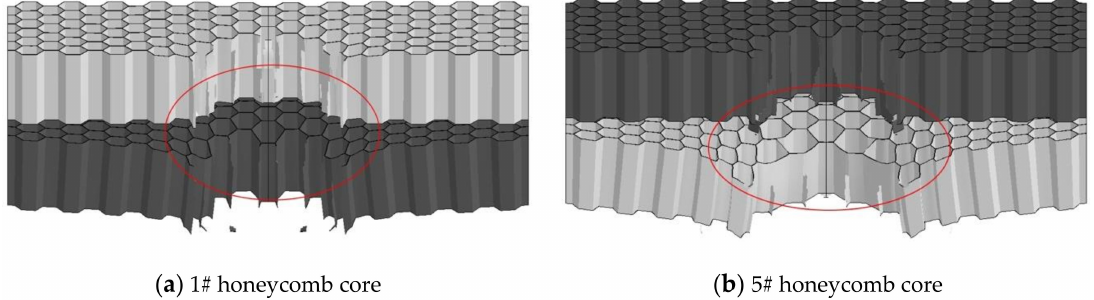
Figure 6. Damage results of 1# and 5# honeycomb core. ( a ) Damage result of 1# honeycomb core; ( b ) Damage result of 5# honeycomb